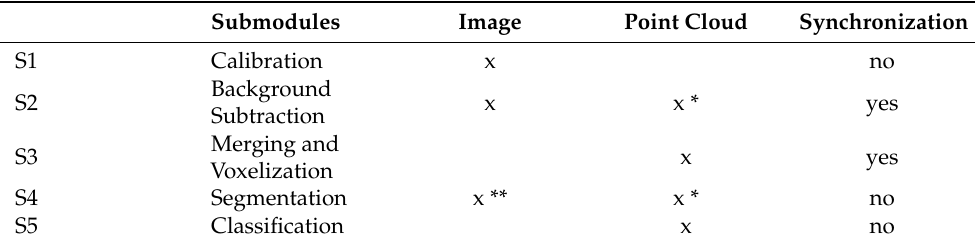
Table 2. Description of partial methods, data types used, and whether synchronization is required. Submodules Image Point Cloud Synchronization S1 Calibration x no Background x x * yes S2 Subtraction Merging and x yes S3 Voxelization